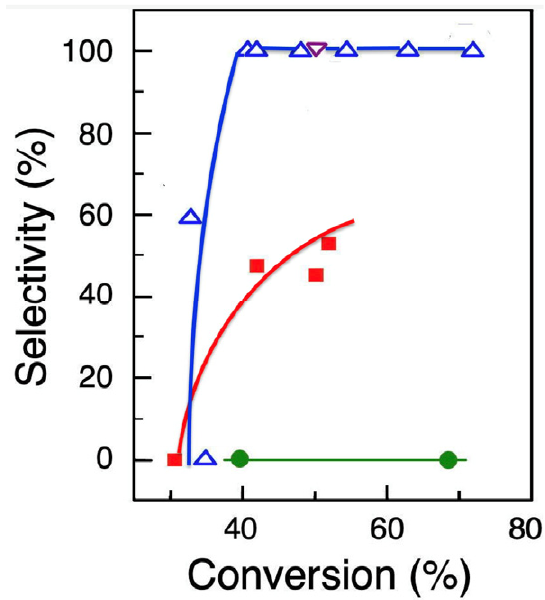
Figure 6. Selectivity to route a 2 over route a 3 versus conversion for different anchors and V/M ratio of 2.5/2.5. (Green circles, red squares, blue upward triangles and purple downward triangles for Zr, Ti, Al, and Ce, respectively.) Excluded are samples containing 10 mol% V and those with poor surface morphology.